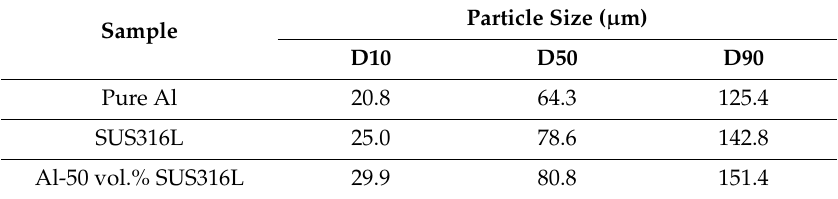
Table 2. Particle size distribution of pure Al, SUS316L and Al-50 vol.% SUS316L composite